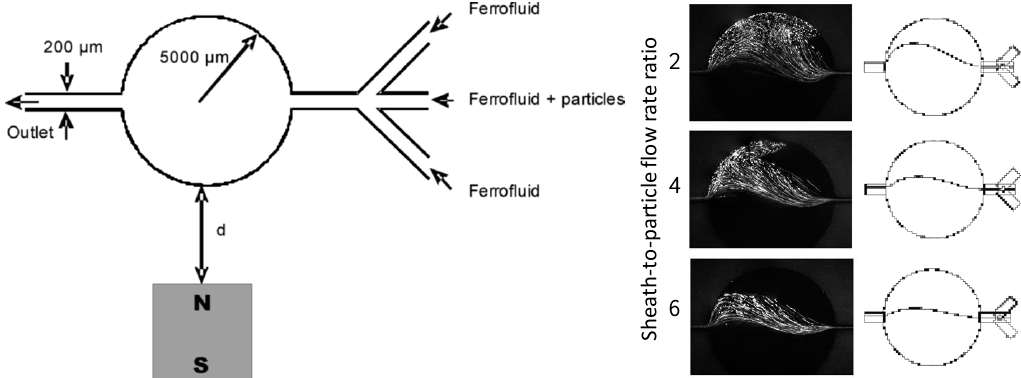
Figure 2. Deflection of pre-focused diamagnetic particles in magnetic fluids under a non-uniform magnetic field: Schematic of the microchannel/magnet setup (left); Comparison of the experimentally and numerically obtained deflections of diamagnetic beads in a diluted EMG 707 ferrofluid (Ferrotec) inside the circular chamber at varying flow rate ratios (right). Adapted with permission from Hejazian and Nguyen [83], 2015 The Royal Society of Chemistry.